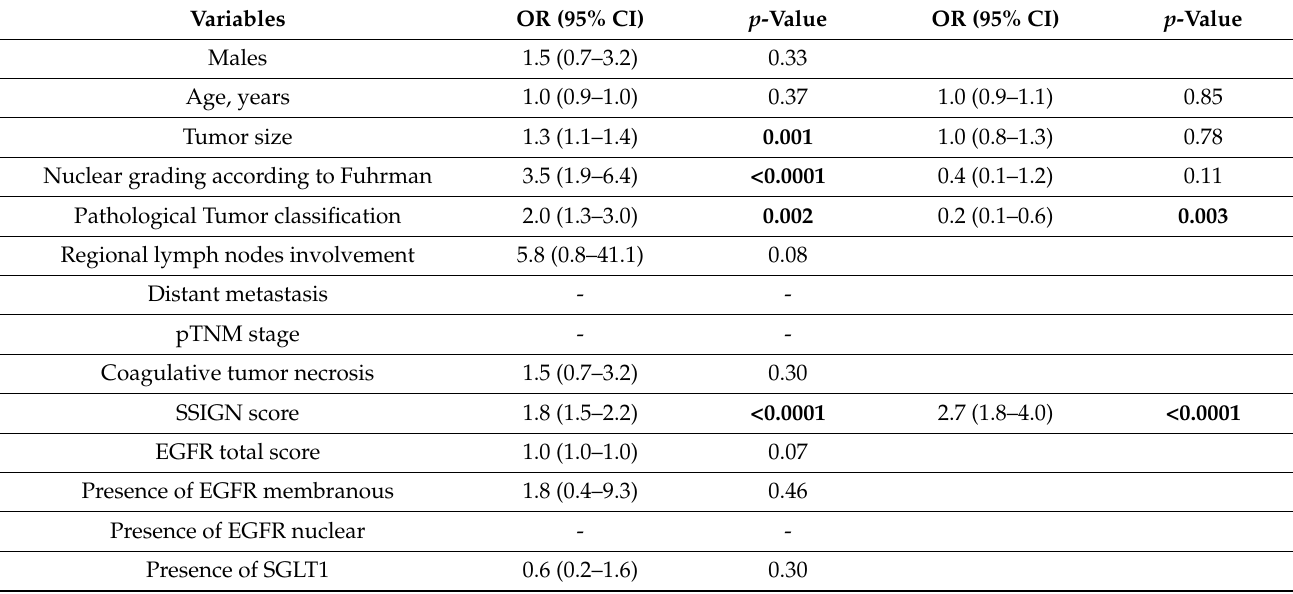
Table 5. Logistic regression to assess the relationship between AWD or DOD and clinicopathological features in CCRCC